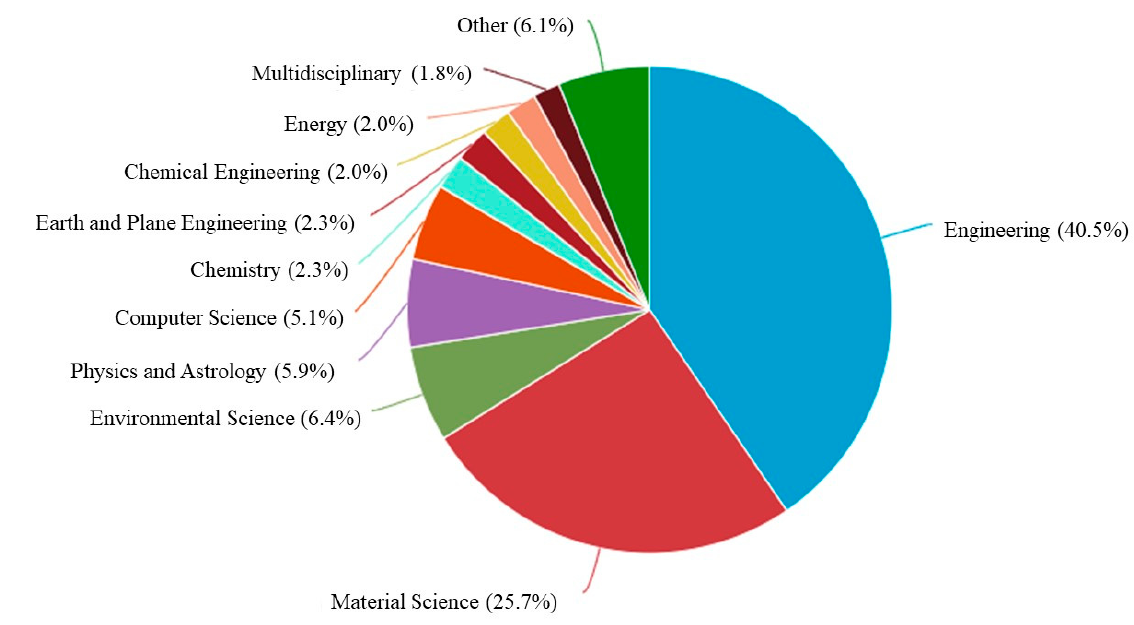
Figure 4. The subject area of articles.